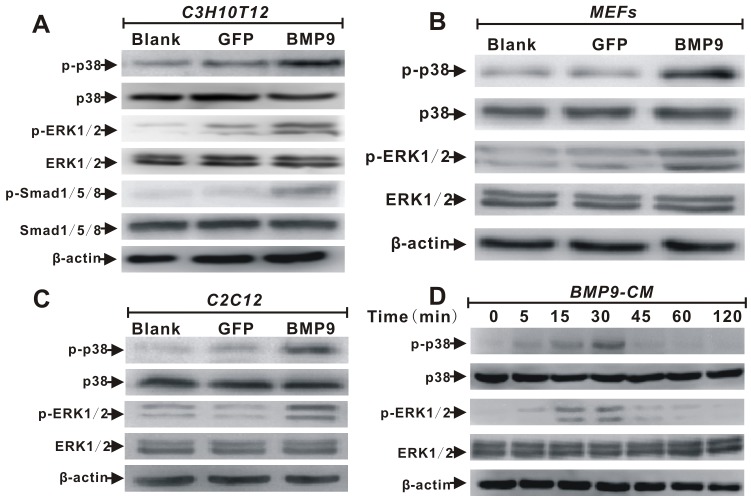
BMP9 induces phosphorylation/activation of p38 and ERK1/2 in MPCs.(A). Western blotting analysis of BMP9-induced phosphorylation of Samd1/5/8, p38 and ERK1/2 in C3H10T1/2 cells. C3H10T1/2 cells were infected with Ad-BMP9 or Ad-GFP (MOI = 5), at 24 hrs, total amount and phosphorylated forms of Smad1/5/8, p38 and ERK1/2 was analyzed by western blotting. β-actin was used to demonstrate equal loading of all samples. (B) Western blotting analysis of BMP9-induced phosphorylation of p38 and ERK1/2 in MEFs. MEFs were infected with Ad-BMP9 or Ad-GFP (MOI = 5), at 24 hrs, total amount and phosphorylated forms of p38 and ERK1/2 was analyzed by western blotting. (C) Western blotting analysis of BMP9-induced phosphorylation of p38 and ERK1/2 in C2C12 cells. C2C12 cell were infected with Ad-BMP9 or Ad-GFP (MOI = 5), at 24 hrs, total amount and phosphorylated forms of p38 and ERK1/2 was analyzed by western blotting. (D) Western blotting analysis of BMP9 conditioned medium (BMP9-CM)-induced phosphorylation of p38 and ERK1/2 in C3H10T1/2 cells. C3H10T1/2 cells were treated with BMP9-CM, total amount and phosphorylated forms of p38 and ERK1/2 was analyzed at indicated time points by western blotting.